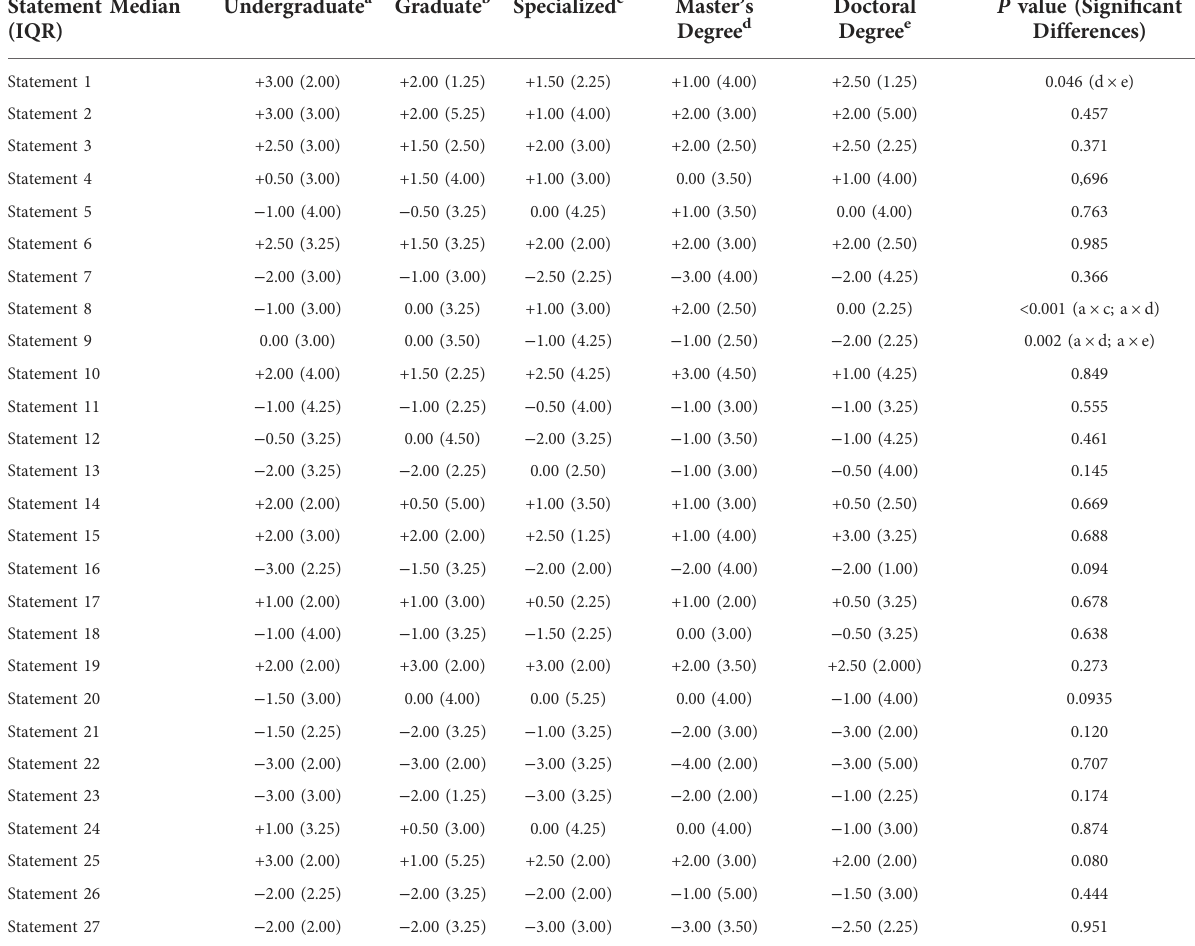
TABLE 3 Analytical assessment of the participants ’ responses according to their academic